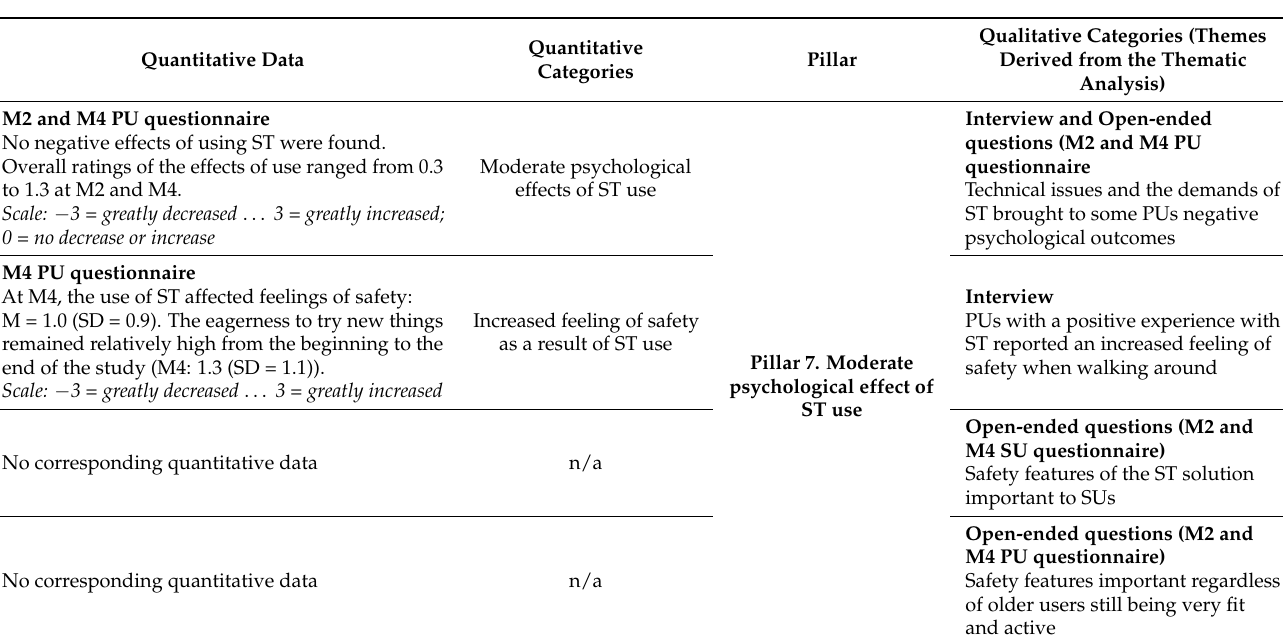
Table 6. A joint display of the connections between the quantitative and qualitative data arising from the study—Pillar